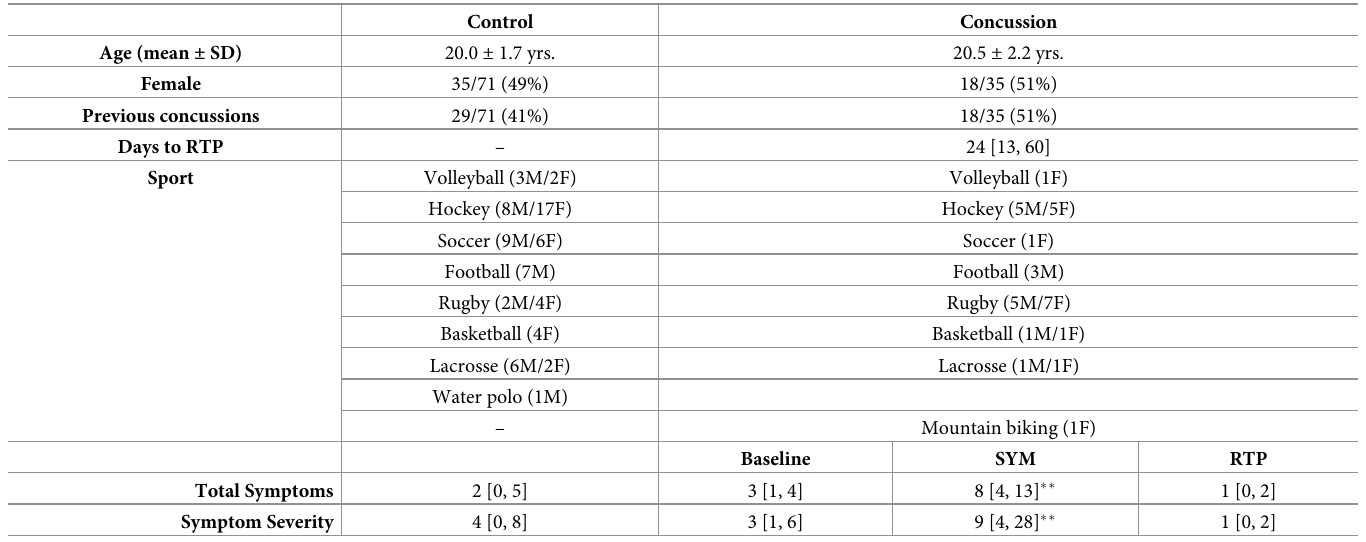
Table 1. Demographic and clinical data for controls and concussed